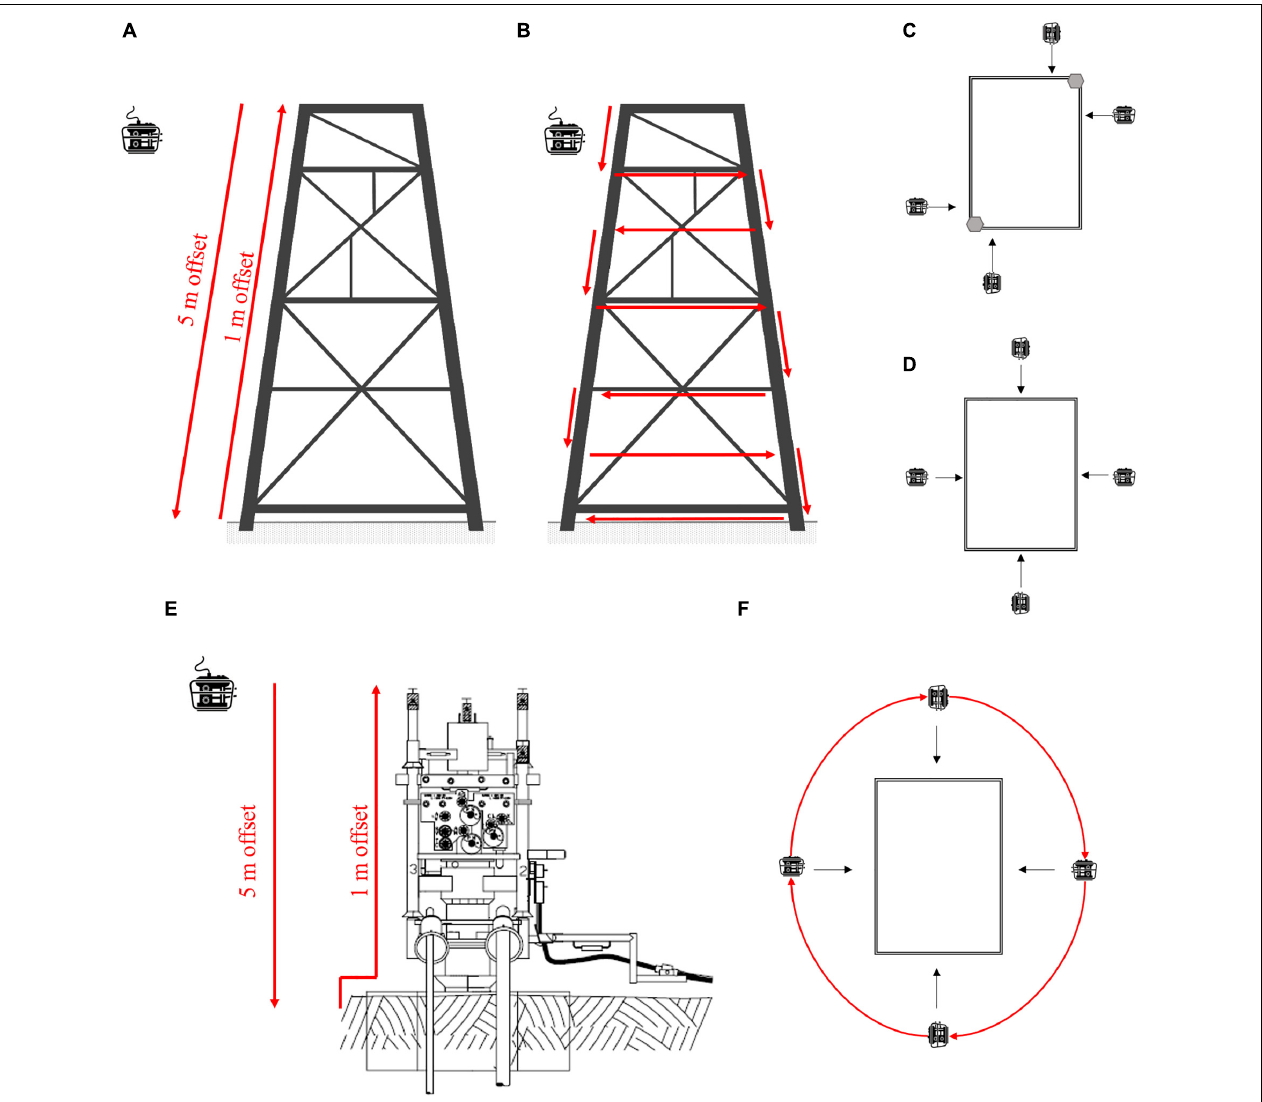
FIGURE 5 | (A) Vertical transects of a platform jacket, (B) horizontal and vertical surveys of a platform jacket, (C) birds eye view of a platform-deployed ROV limited to certain areas of a jacket and (D) birds eye view of vessel-deployed ROV survey of a jacket. (E) Wells are typically < 9 m in height and surveyed by performing a vertical survey close to and further away and (F) by moving the ROV around the well